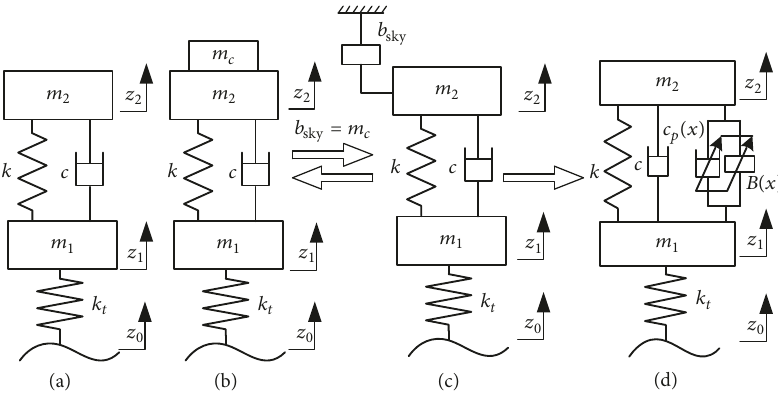
Figure 4: Equivalent relationship between quarter vehicle models: (a) unload passive suspension; (b) full-load passive suspension; (c) virtual skyhook inerter system; (d) semiactive inertance control suspension.